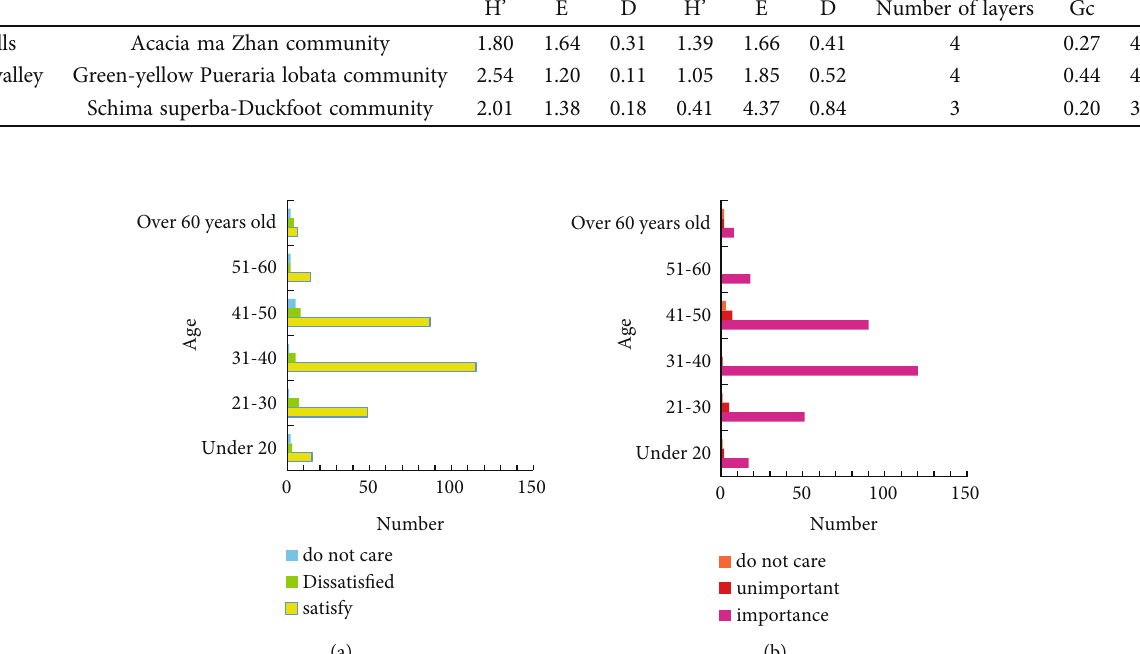
Figure 6: Survey results of satisfaction and importance. (a) Survey of villagers ’ satisfaction. (b) Survey of villagers ’